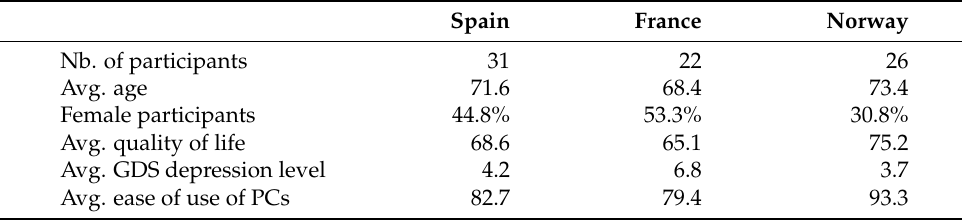
Table 6. Information about the participants in the human evaluation.